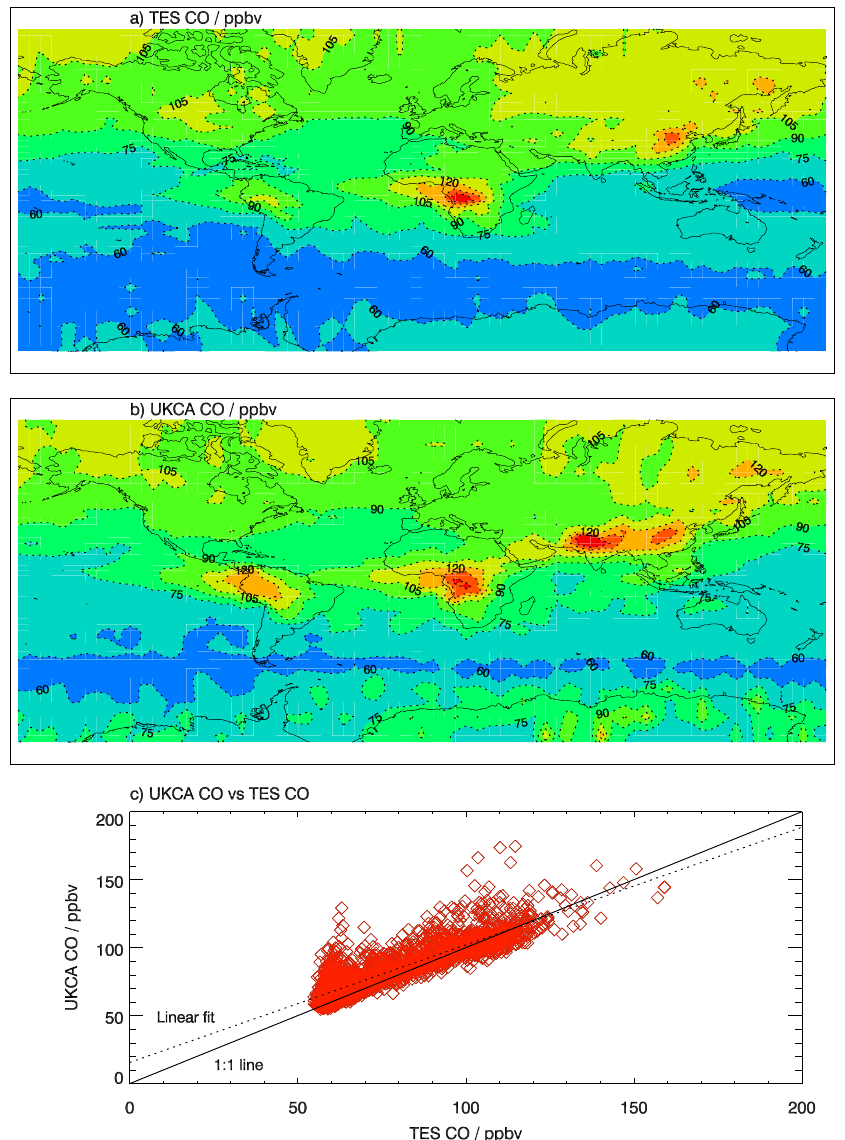
Fig. 28. Mid and lower free tropospheric CO concentrations from (a) TES and (b) UKCA StdTrop for July–August 2006. Data from 7 TES pressure levels between 800 and 400hPa were used. A scatter plot of UKCA CO concentrations against TES CO concentrations is shown in (c) , along with the least squares linear fit and the 1 : 1 line. TES sampling and operators have been applied to the model output. The data have also been smoothed by averaging on a 4 ◦ × 5 ◦ grid.